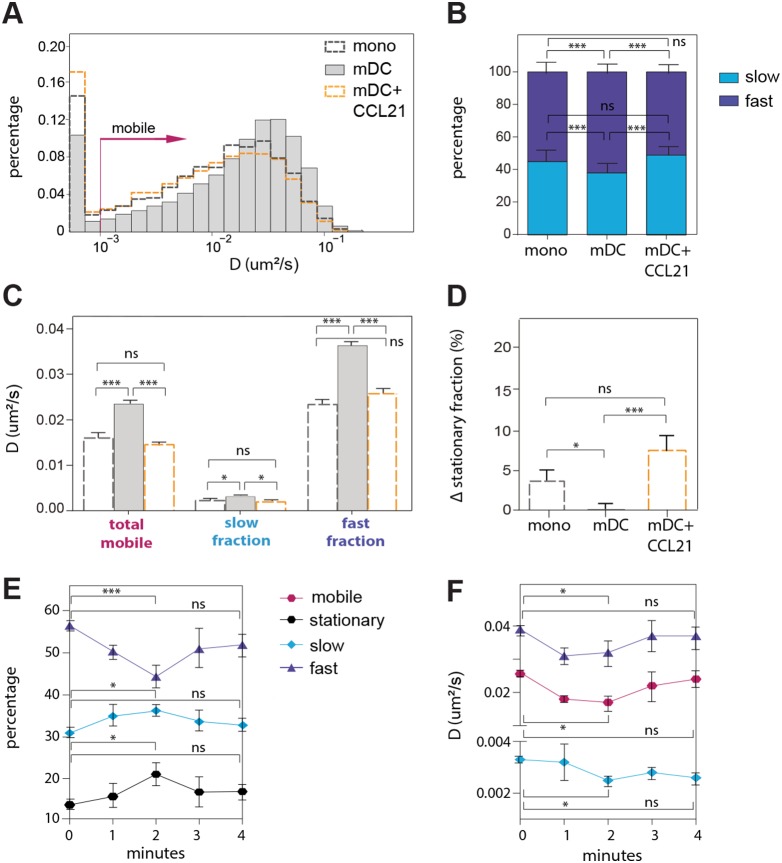
Mobility of LFA-1 on mDCs after activation with CCL21.(A) Overlay histograms of LFA-1 diffusion on monocytes (4578 trajectories), resting mDCs (26756 trajectories) and CCL21 activated mDCs (4213 trajectories). (B) Percentage of total mobile LFA-1 population (normalized to 100%) displaying slow and fast diffusion on monocytes, mDCs and 2 min CCL21 activated mDCs. (C) Diffusion coefficient of the total mobile population, and slow and fast diffusing fractions of LFA-1 on monocytes, mDCs and 2 min CCL21 activated mDCs. (D) Stationary fraction of LFA-1 on monocytes, mDCs and CCL21 activated mDCs, displayed as the difference from the total stationary fraction on mDCs, which serve here as the default. Data from A–D on CCL21 activated mDCs is based on 22 cells in independent experiments from 3 different donors. (E) Percentage of the stationary, slow and fast diffusing LFA-1 molecules at different time points after CCL21 activation. (F) D values for the total mobile, and slow and fast fractions of LFA-1 at different time points after CCL21 activation. Data from E and F is based on 11 cells, 11 independent samples and around 2000 trajectories per time point. A–F Means ± SEM are depicted. The One-way ANOVA followed by the Tukey multiple comparison test were used to determine significant differences between means. The resulting P values are indicated as follows: ns (P>0.05); * (P<0.05) and *** (P<0.0001).